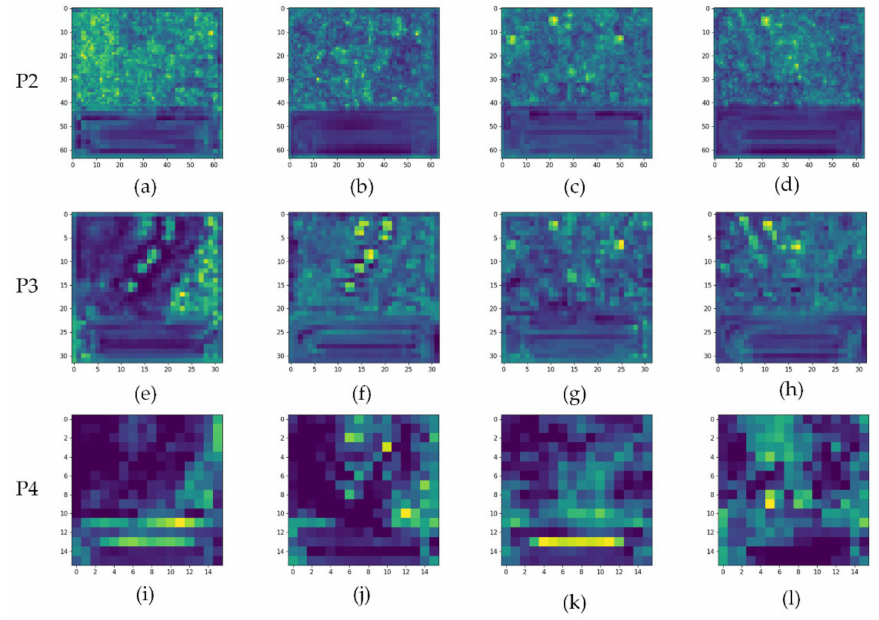
Figure 17. Feature map visualization results of feature pyramid with and without Bi-DFFM. ( a , c , e , g , i , k ) represent results without Bi-DFFM. ( b , d , f , h , j , l ) represent results with